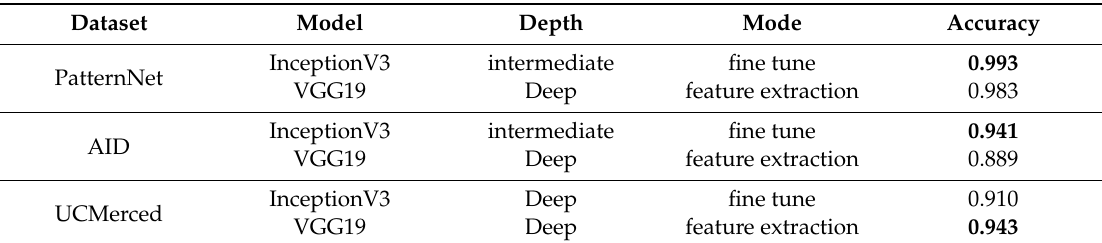
Table 9. Best test set accuracy for Inception V3 and VGG19 version for each Dataset using Adamax (2e-3) optimizer.